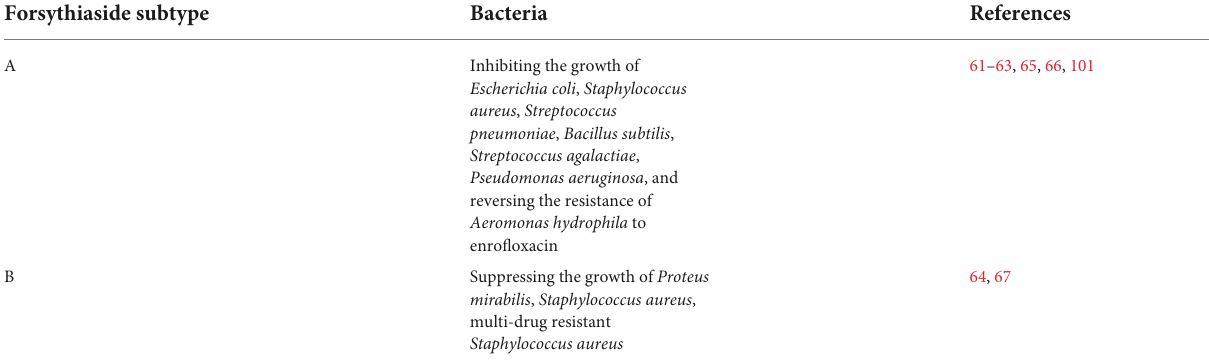
TABLE 3 Antibacterial effects of